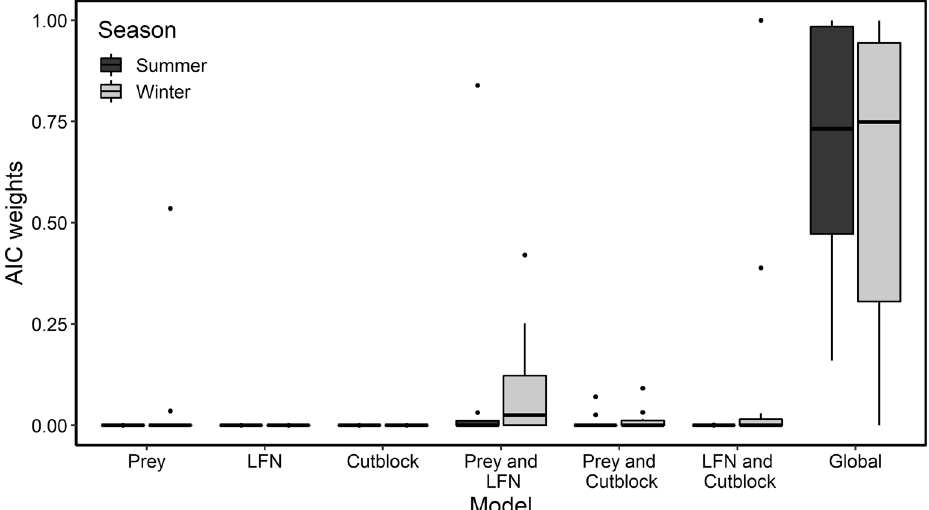
Figure 2. Akaike’s information criterion (AIC) weight distribution for summer (April 1–September 30) and winter (October 1–March 31) integrated step selection analysis candidate models for Prince George South, 2018–2020. Outliers are represented by